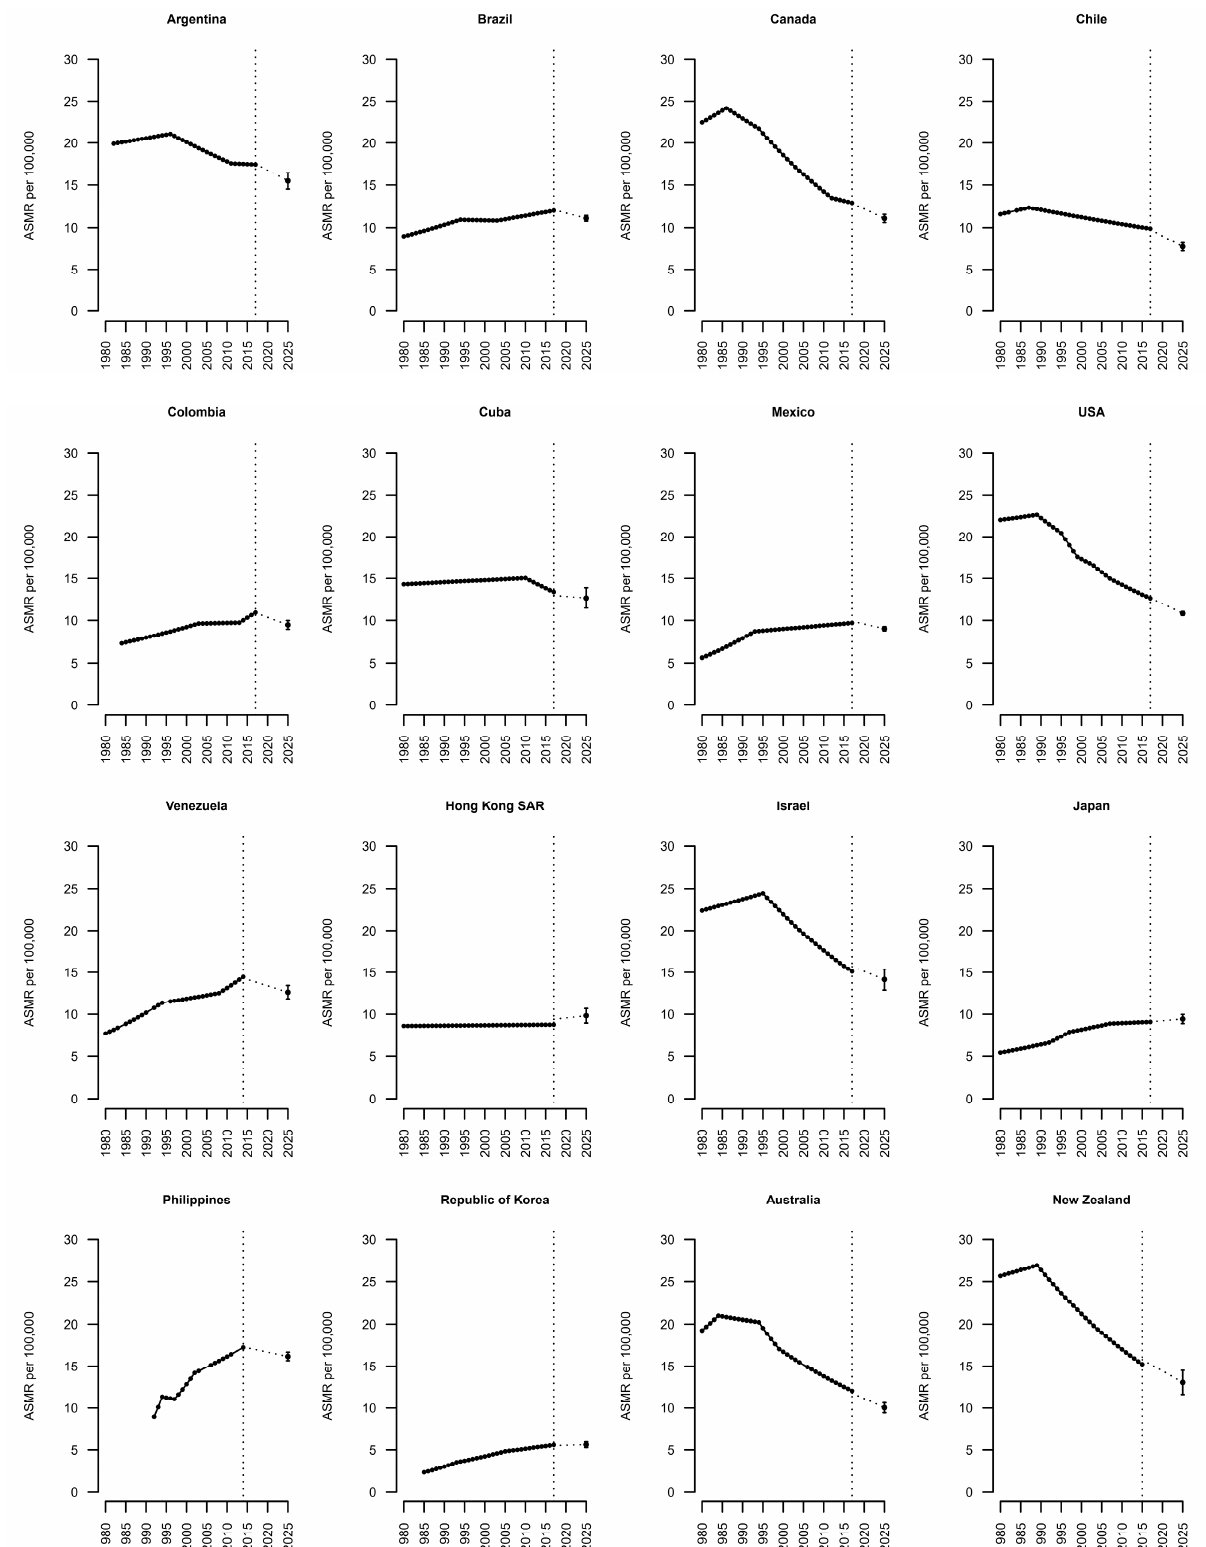
Figure 2. Joinpoint analysis of trends in breast cancer mortality in major countries worldwide from 1980 to 2017 according to data availability.